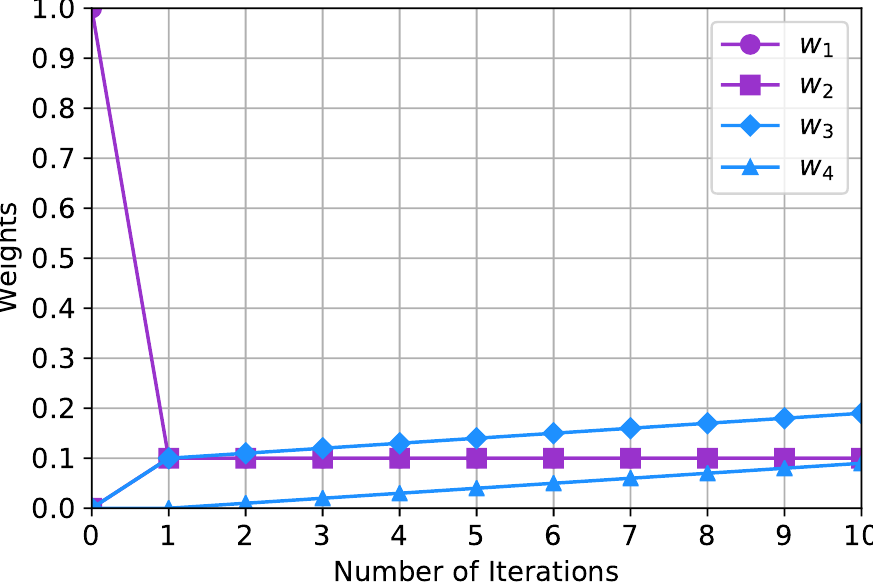
Figure 2. Weight changes upon consensus-based